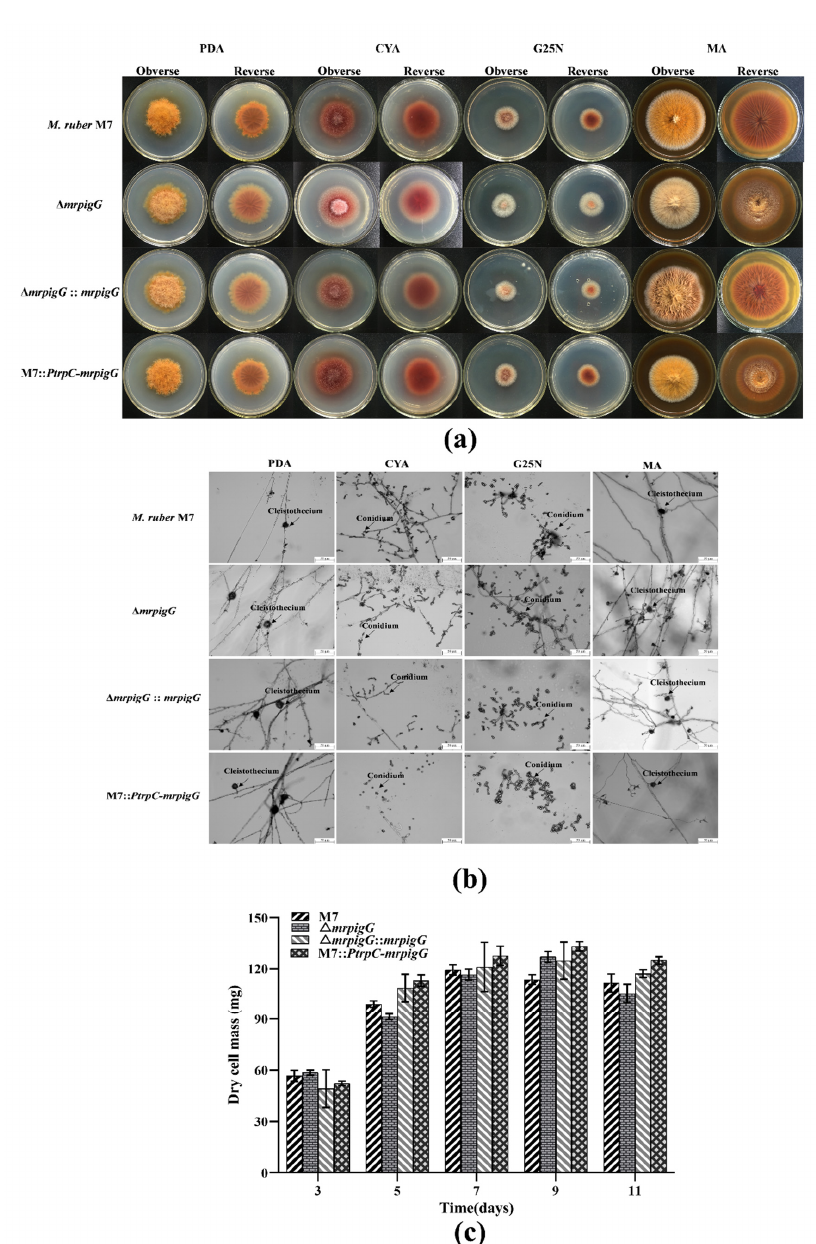
Figure 5. Morphologies and biomasses of ∆ mrpigG , ∆ mrpigG :: mrpigG , M7:: PtrpC - mrpigG and M. ruber M7. ( a ) Colonial morphologies on potato dextrose agar (PDA), Czapek yeast extract agar (CYA), malt extract agar (MA) and glycerol nitrate agar (G25N) plates. ( b ) Cleistothecia and conidia formation (at 10 days) of the M. ruber M7 and the mrpigG transformants on different plates (PDA, CYA, G25N and MA) at 28 ◦ C. ( c ) Biomass (dry cell weight). Experiments were performed in triplicate. Error bars indicate standard